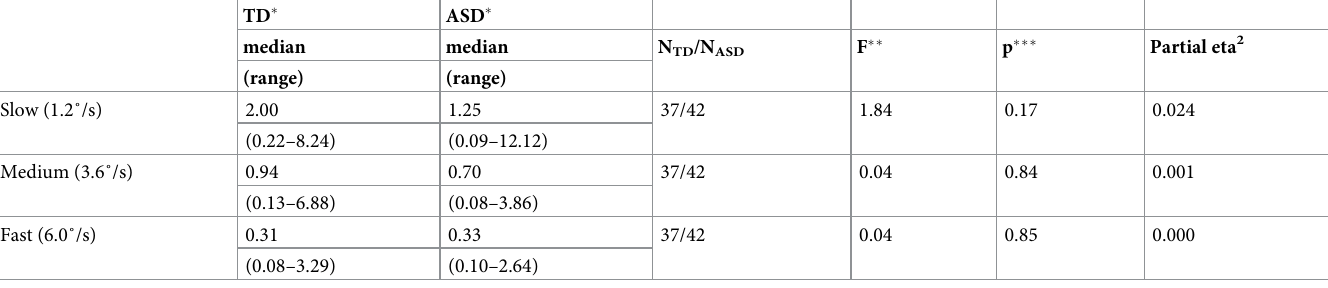
Table 3. Power of gamma response (GR) in TD and ASD groups of children and analysis of group differences (ANCOVA